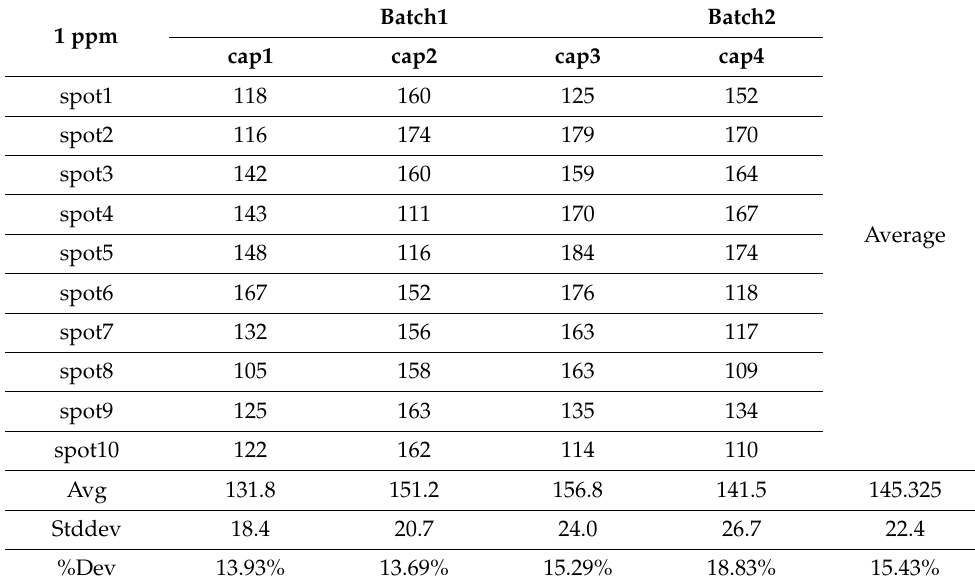
Table 2. Peak heights and statistics for SERS measurements of 1 ppm caffeine in water in four gold SERS-active capillaries prepared in batches (spectral conditions the same as those in Figure